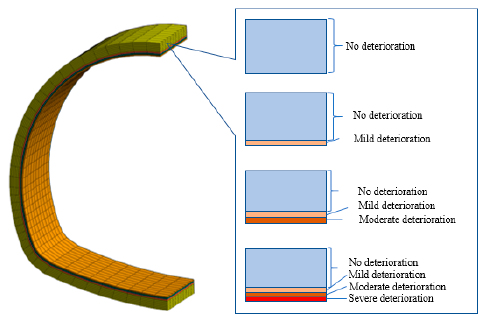
Figure 17. Calculation model of lining degradation. Table 3. Parameters of concrete in the simulation [20,21].